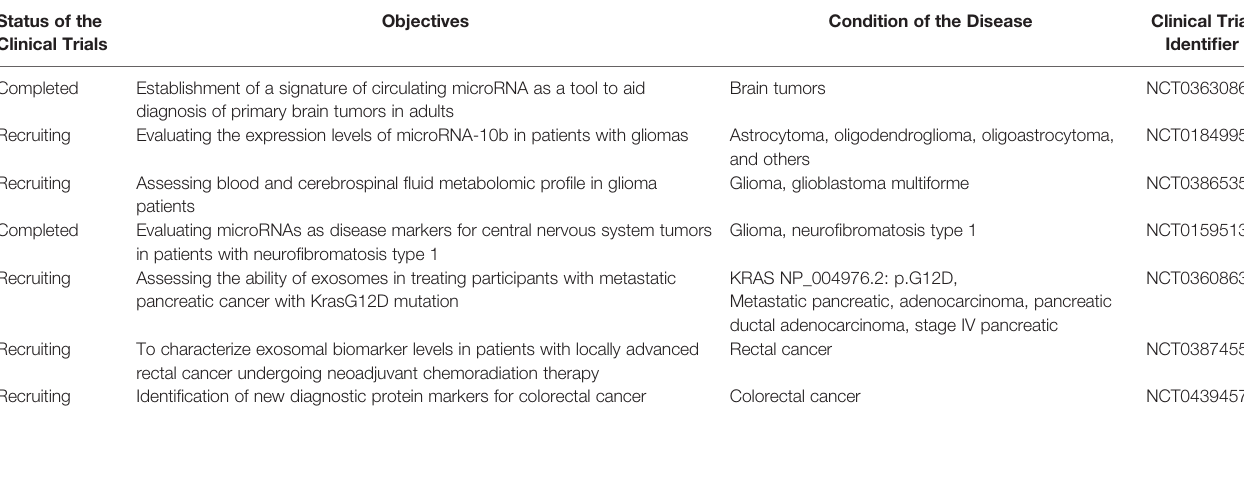
TABLE 4 | Examples of clinical trials done on the roles of exosomes as biomarkers or in treatment agents for glioma and other